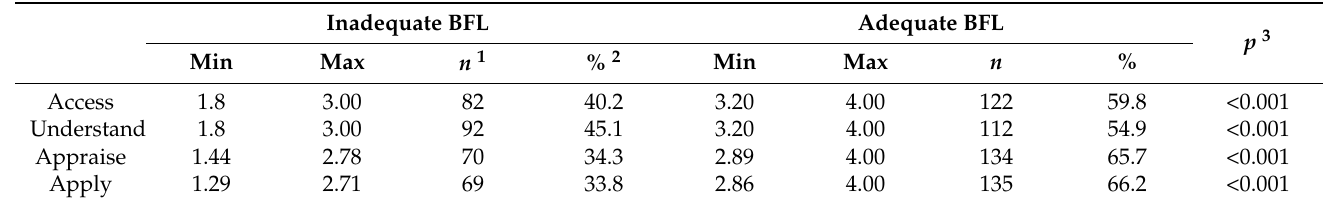
Table 3. Cut-off points between inadequate and adequate BFL and descriptive analysis of